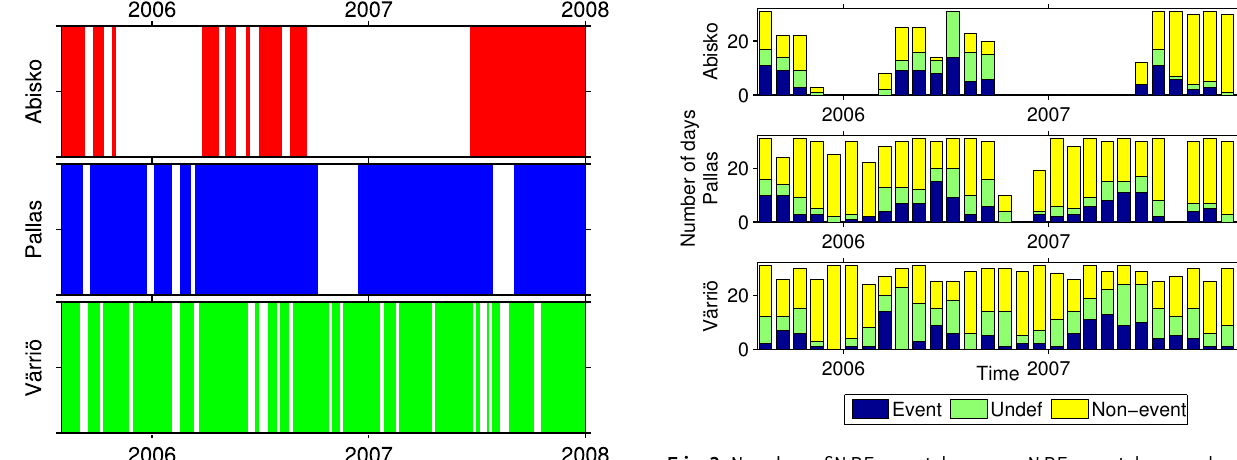
Fig. 3. Number of NPF event days, non-NPF event days, and unde- fined days in all measurement